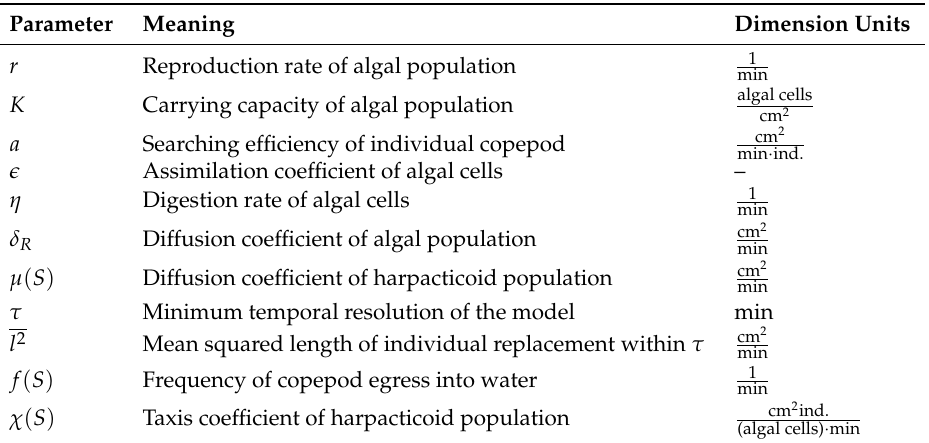
Table 2. Dimension of parameters in model